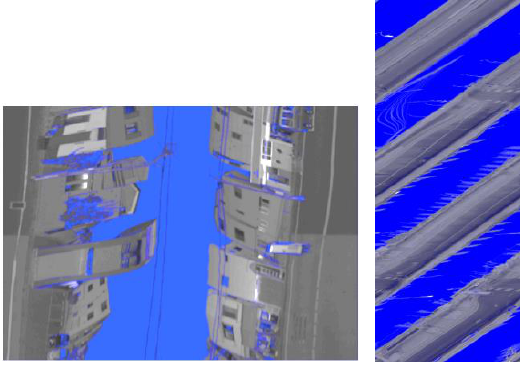
Figure 4. Conventional point-cloud